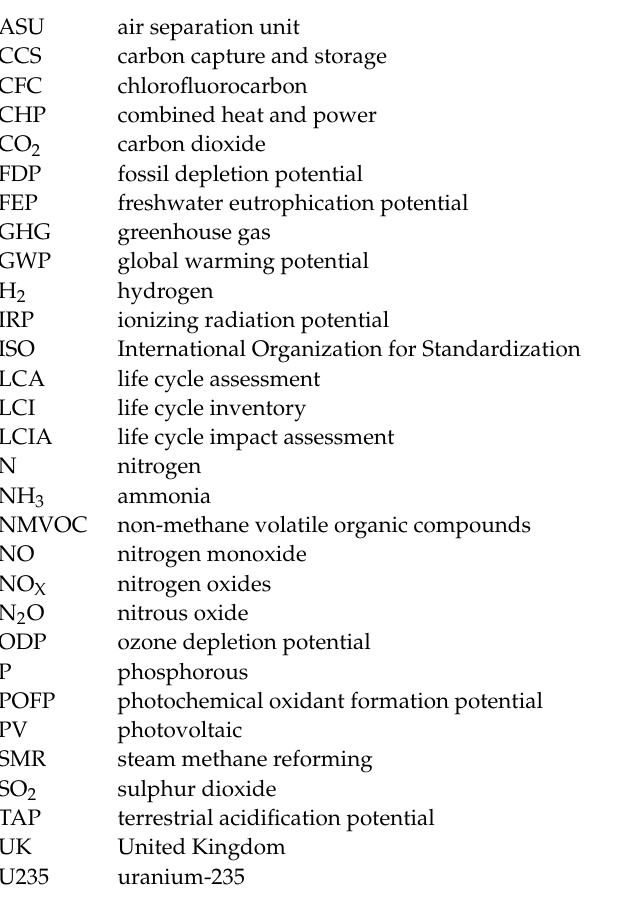
Table S3: Life cycle inventory of ammonia-based power generation, FU 1 kWh of